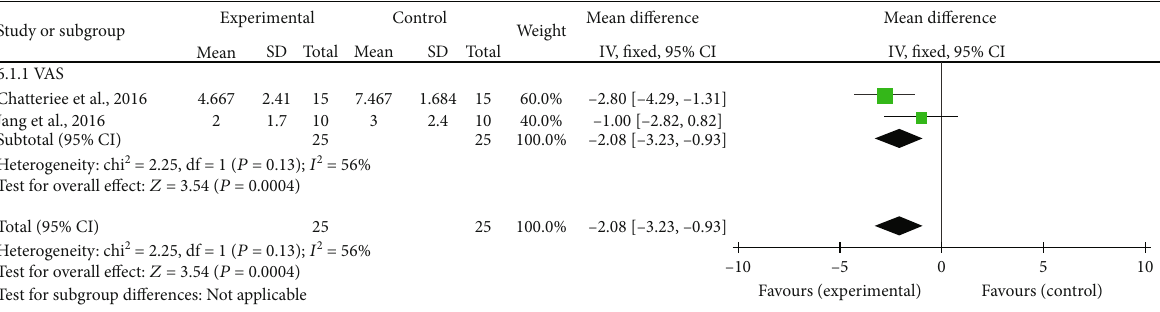
Figure 2: Shoulder pain: forest plot of the articles that used the Visual Analog Scale (VAS). Legend: SD: standard deviation; CI: con fi dence interval; VAS: Visual Analog